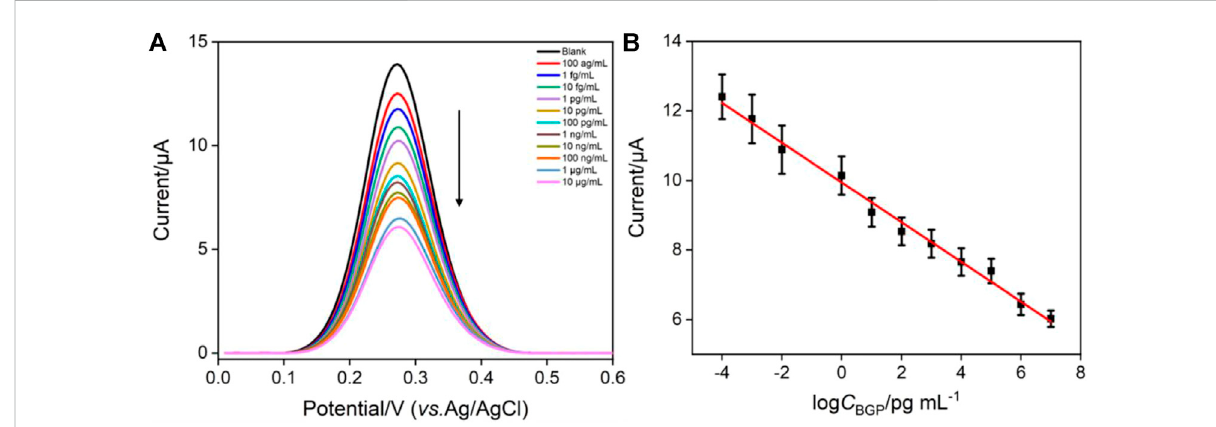
FIGURE 5 (A) DPV curves obtained on the developed immunosensors after incubation with different concentrations of BGP. (B) Corresponding linear regression curve. Error bars represent the standard deviation of three measurements.